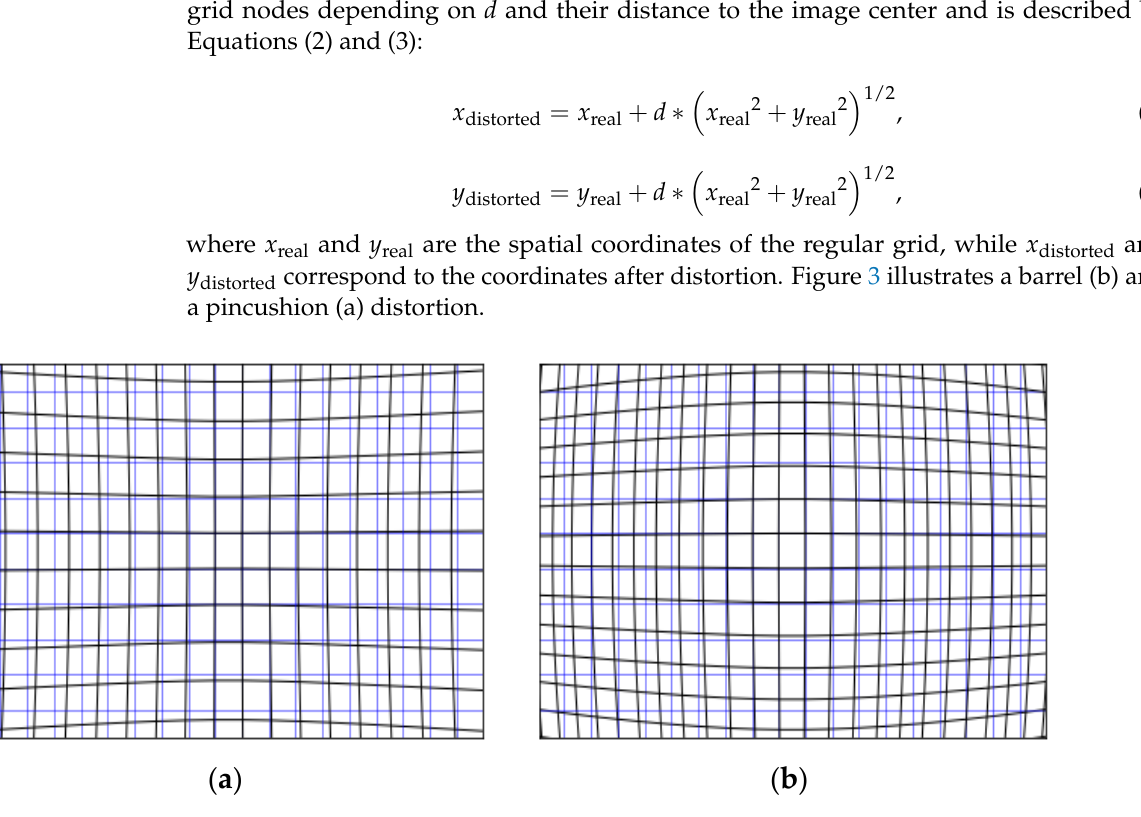
Figure 3. Distorted (in black) and regular (in blue) grids for two distortion coefficients. ( a ): d > 0, pincushion distortion. ( b ): d < 0, barrel distortion.